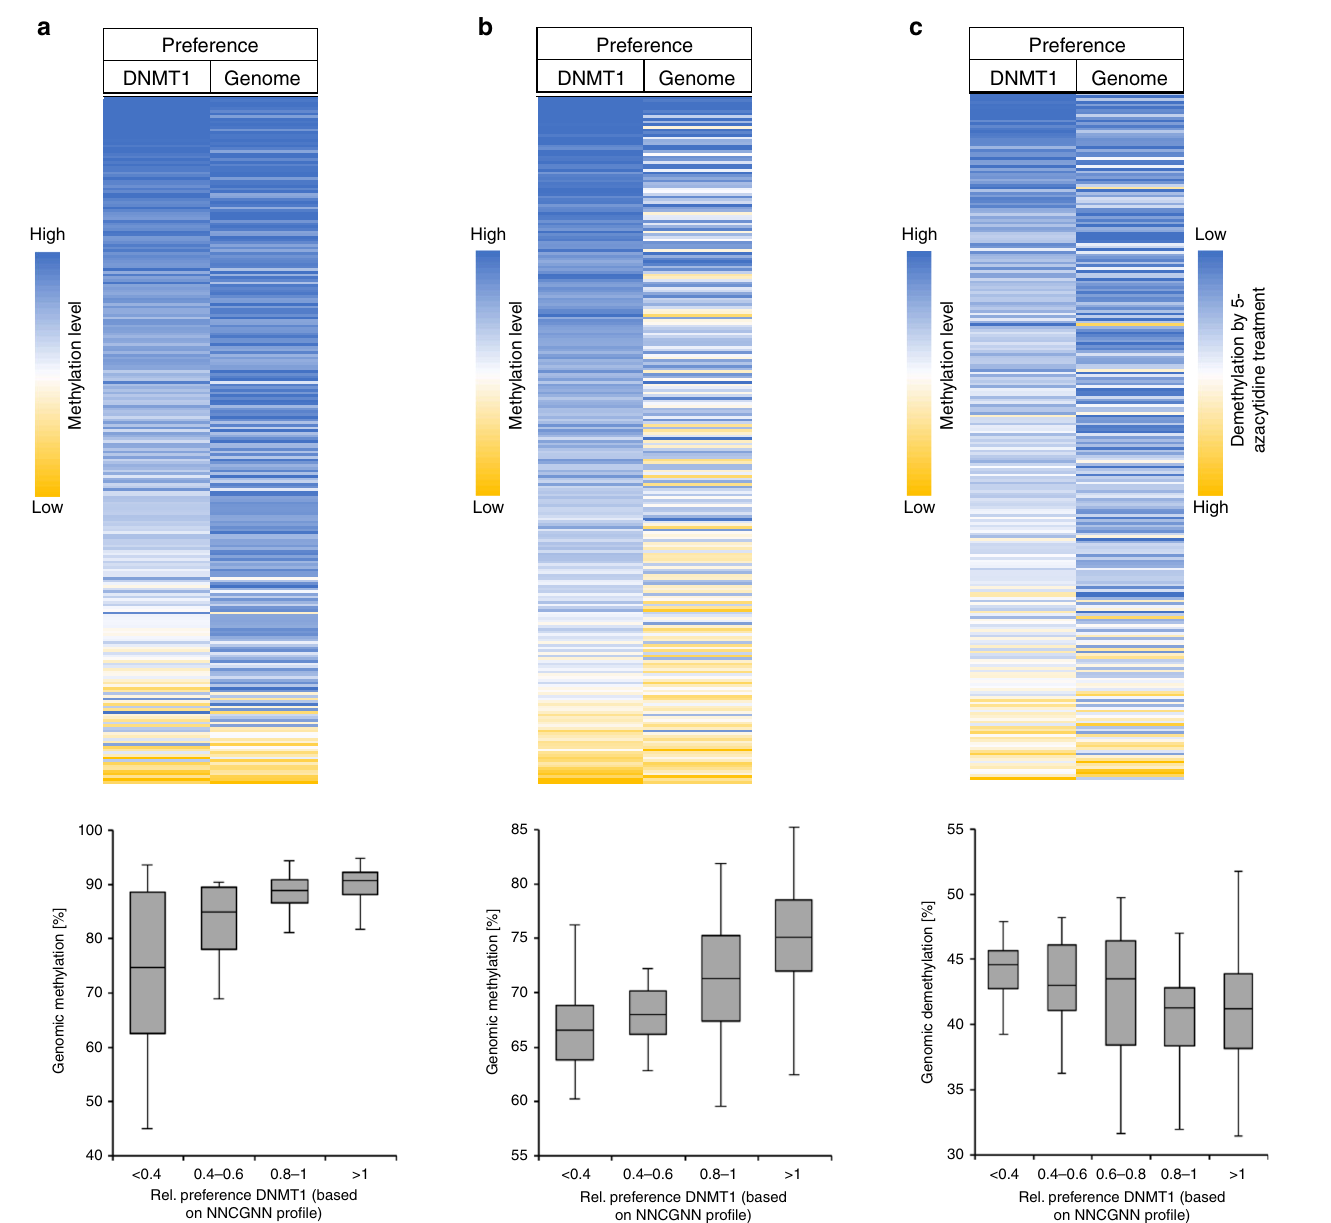
Fig. 6 Comparison of DNMT1 fl anking preferences with genomic DNA methylation. a Correlation of the DNMT1 fl anking sequence preference (DNMT1) with genome-wide CpG methylation patterns in human cells (Genome) determined by whole genome bisul fi te analysis in human ES cells 39 . The top image shows the average methylation levels of CpG sites with different NNCGNN fl anks as heatmap. The p value of the correlation is 6.77 × 10 − 13 . The lower image shows a box plot of the genomic methylation levels of CpG sites in de fi ned ranges of DNMT1 preferences. The lines show the medians, the boxes show the 1st and 3rd quartile and the whiskers display the data maximum and minimum. b Correlation of the DNMT1 fl anking sequence preference (DNMT1) with genome-wide CpG methylation patterns (Genome) determined by reduced representation genome bisul fi te analysis in lung cancer cells 41 . The image shows the average methylation levels of CpG sites with different NNCGNN fl anks as heatmaps and the corresponding box plot as described in ( a ). The p value of the correlation is 1.98 × 10 − 10 . c Anticorrelation of the DNMT1 fl anking sequence preference with genome-wide CpG demethylation after treatment of lung cancer cell with 5-azacytidine 41 . The image shows the DNMT1 preferences of NNCGNN fl anks (DNMT1) and average levels of genome demethylation of CpG sites in NNCGNN fl anks (Genome) as heatmaps and the corresponding box plot. Relative DNA demethylation is calculated as Δ methylation/initial methylation. The p value of the anticorrelation is 7.63 × 10 − 5 . The p values of (anti)correlations in ( a – c ) were based on the Pearson correlation coef fi cients ( r -factor) and the Z -statistics of the distribution of r -factors determined after randomization of one of the data sets. Source data are provided as a Source Data fi